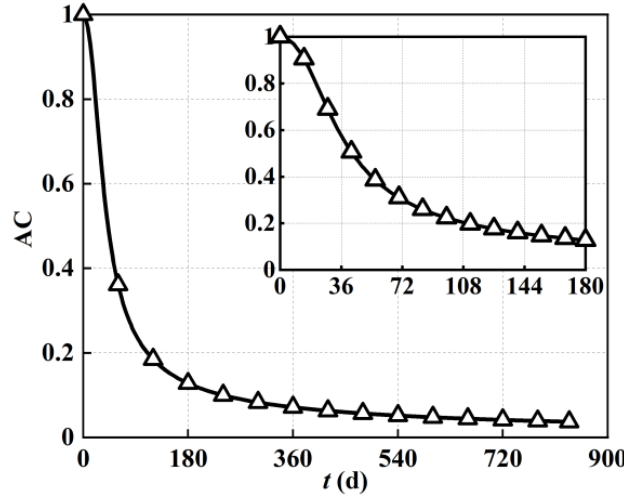
Figure 10. The variation in reaction activity within the porous anode electrode over operating time during 20,000 h of steady − state operation.